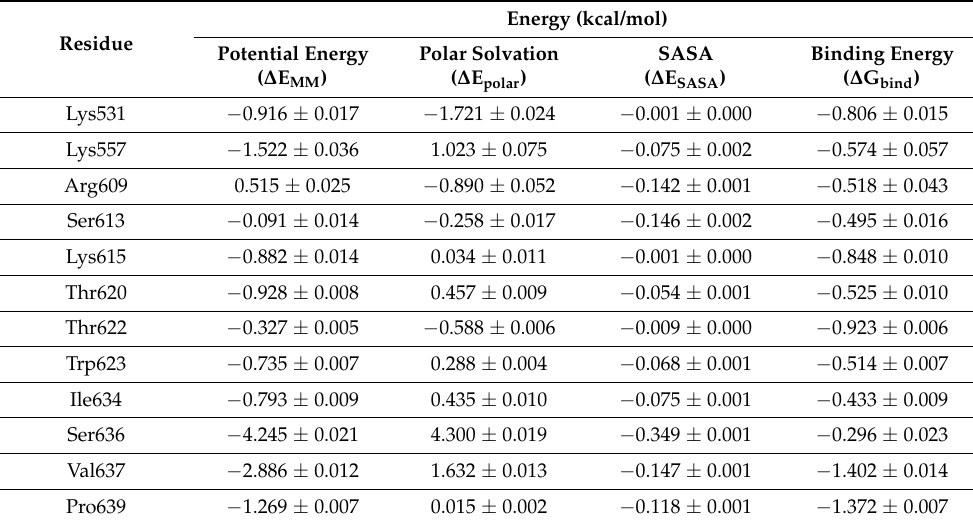
Table 4. Per residue energy contribution of PGG interacting with the binding site of